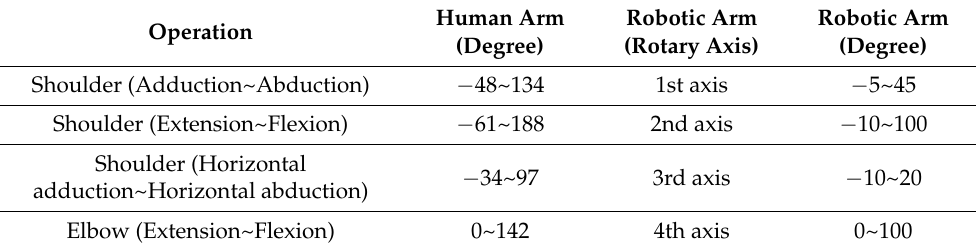
Figure 2. Schematic diagram of robotic arm shoulder and elbow rotating axis operation. Table 1. Motion range of human joints and design of the rotational axis of the robotic arm